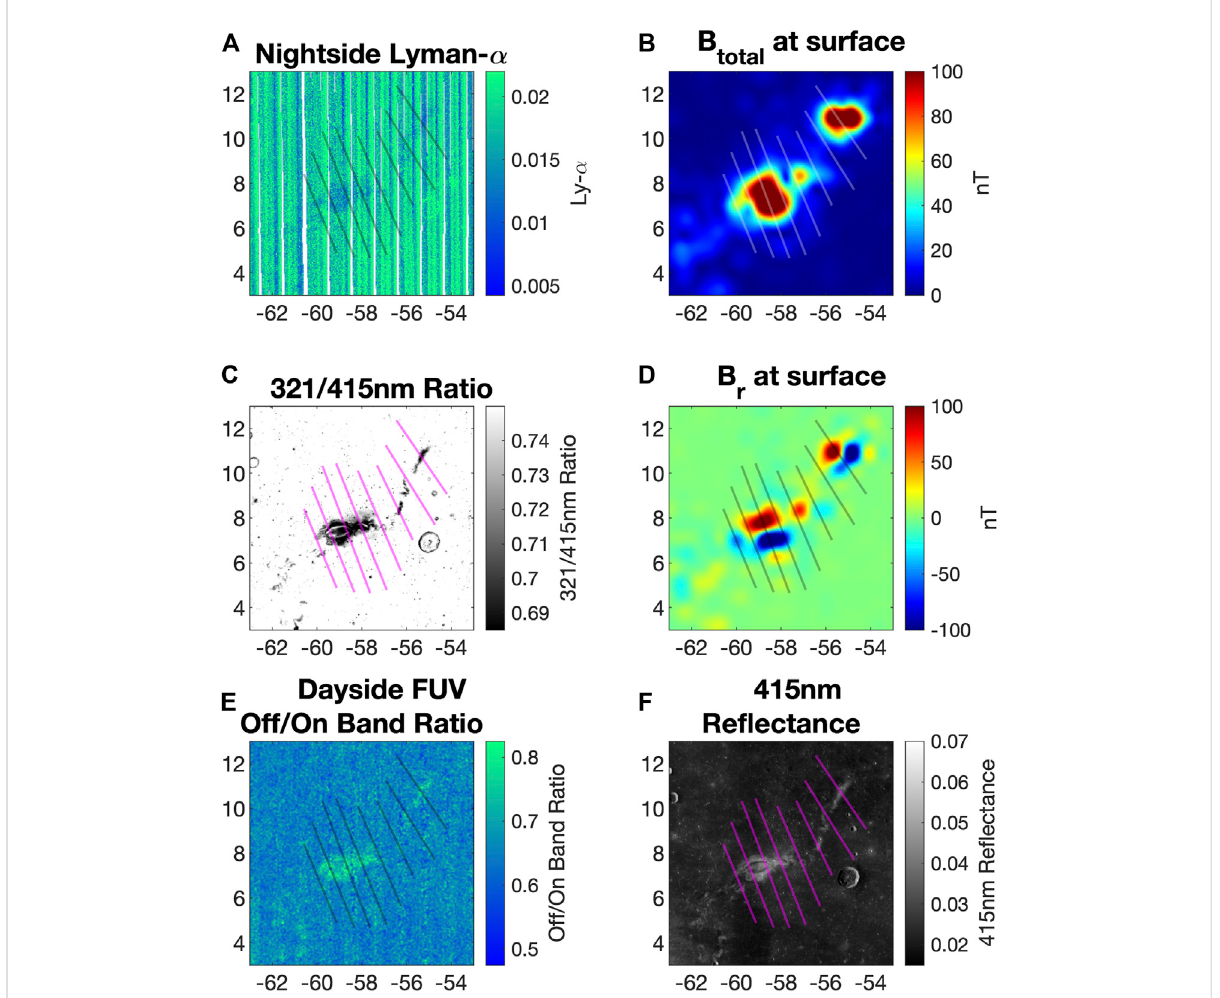
FIGURE 11 FortheregionofReinerGamma, (A) showsLAMPnightsideLyman- ɑ albedo, (B) displaystheLunarProspectorderivedtotal(B total ) fi eldintensity at the surface, (C) visualizes the LROC WAC NUV 321/415 nm ratio, (D) visualizes the Lunar Prospector derived radial (B r ) fi eld component intensity, (E) visualizes the LAMP dayside FUV Off/On Band ratio, and (F) visualizes the LROC WAC 415 nm re fl ectance. Spatial pro fi les are contrasted in either pink or black to show the variety of morphology